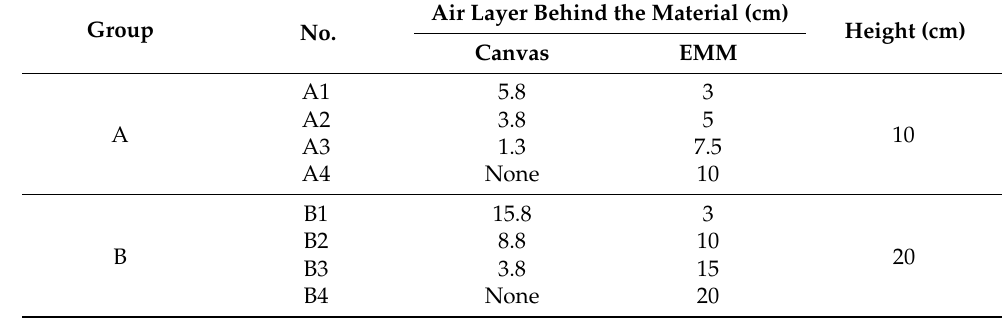
Figure 1. Materials.